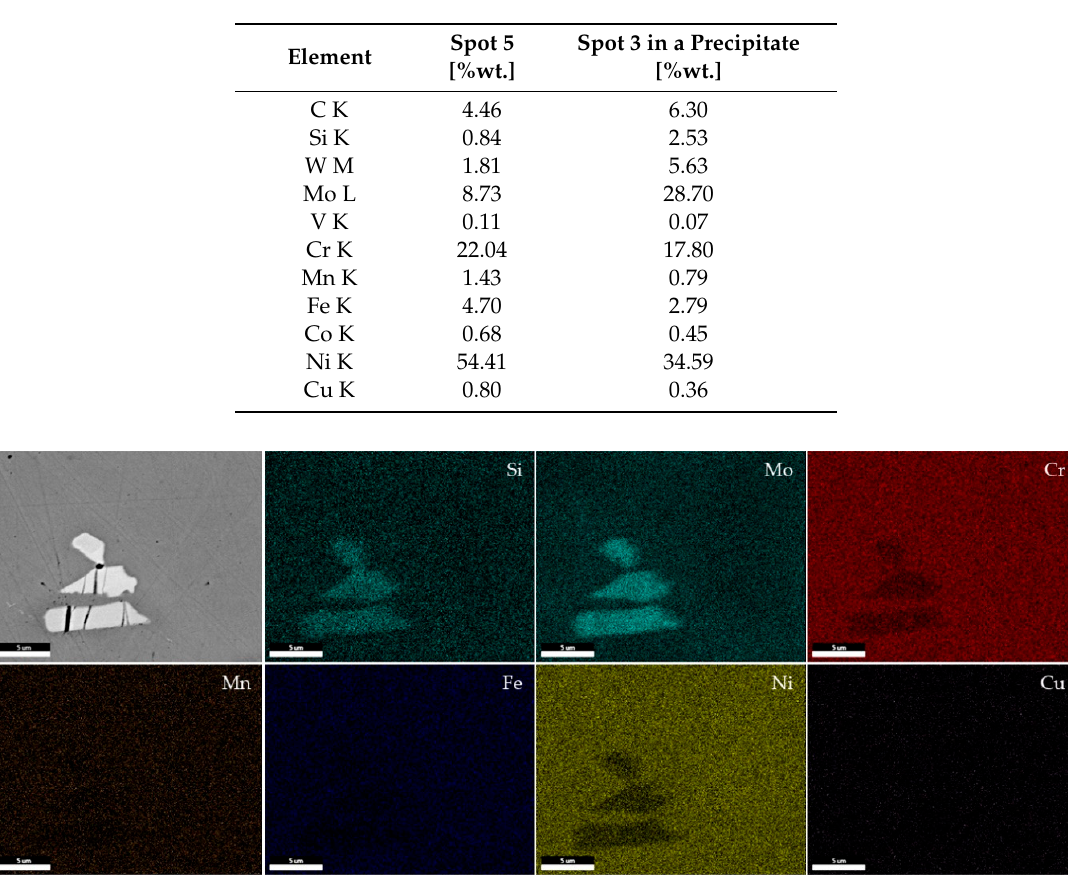
Figure 11. SEM image of the Hastelloy C-22 specimen manufactured under air without thermal treatment and EDS analysis (analyzed specimen 1.2). Table 4. EDS composition for the Hastelloy C-22 specimen manufactured under air without thermal treatment.